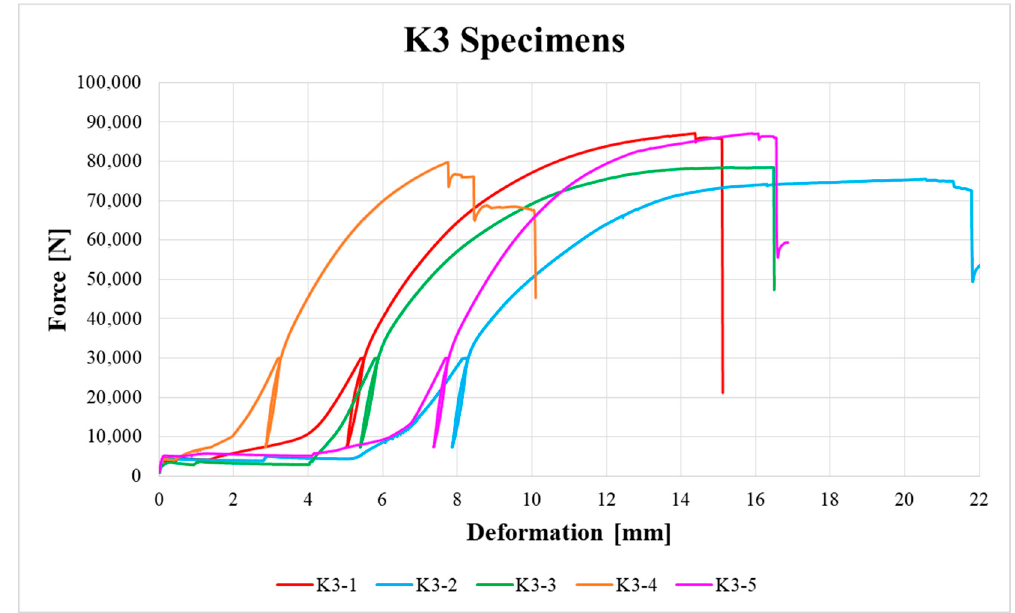
Figure 14. Load–deformation curves of K3 specimens.